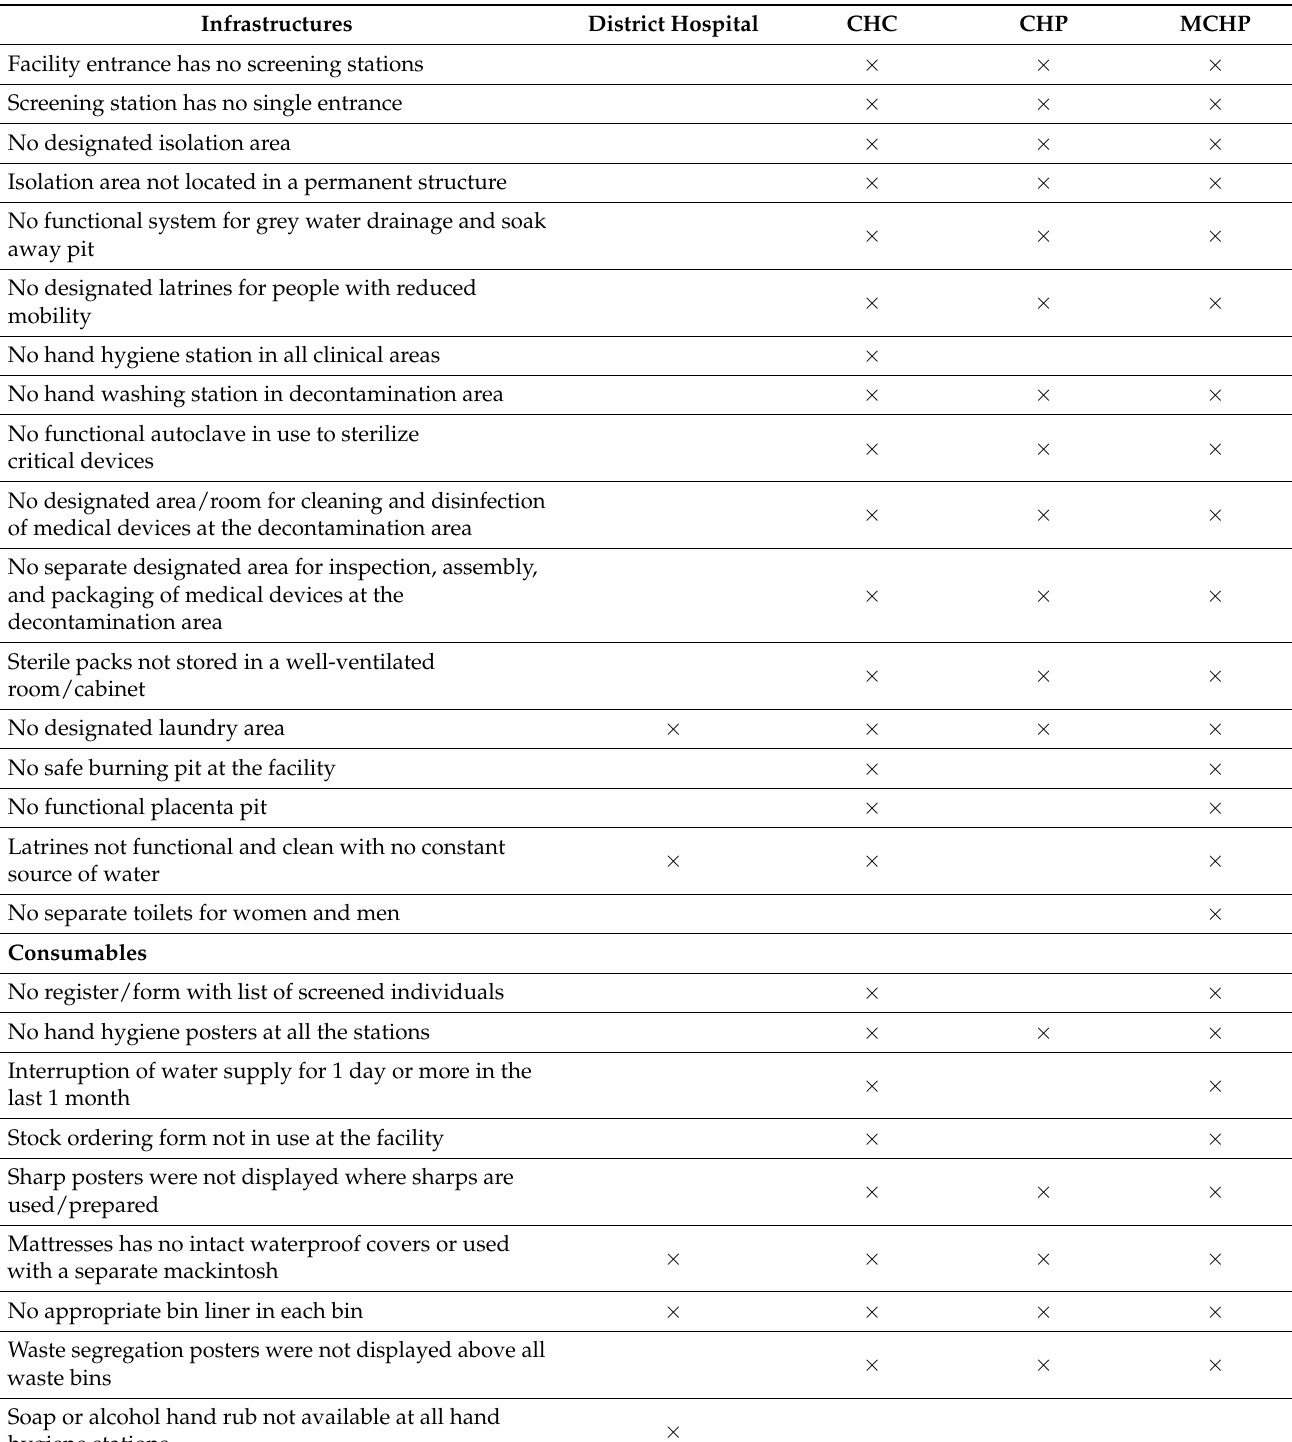
Table 6. Gaps in infrastructure and consumables for Kenema district hospital and Peripheral Health Units, Sierra Leone (2018). (Blank spaces = no identified gap; × = gap